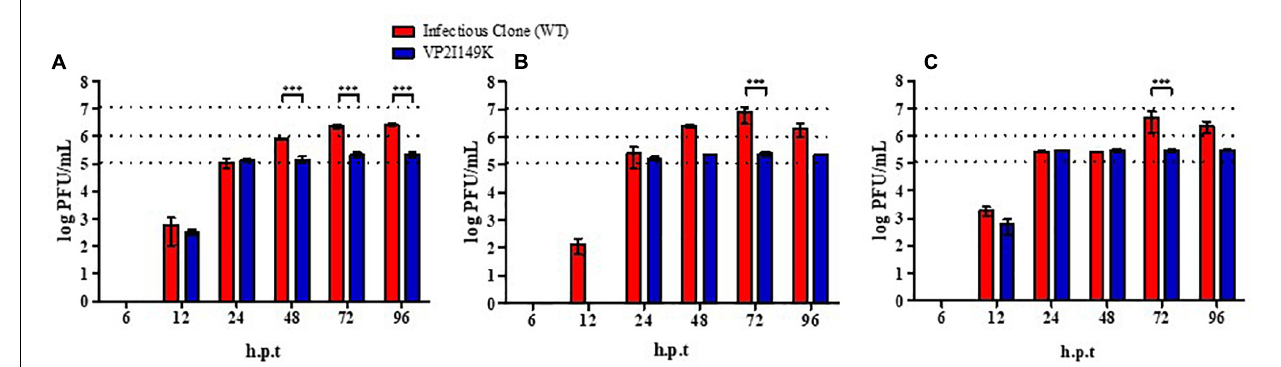
FIGURE 3 | Infection profile of WT and VP2 I149K mutant upon reverse-transfection. (A) 25 ng, (B) 50 ng, or (C) 125 ng of viral RNA purified from WT or VP2 I149K mutant were reverse-transfected into NSC-34 cells. At the indicated time-points p.i., supernatants were harvested and the virus titers were determined by plaque assay in RD cells. One representative set of two independent experiments is shown. Data were expressed as mean ± SD. A two-way ANOVA with Bonferroni correction was used to evaluate statistical significance. ∗∗∗ p < 0.001.